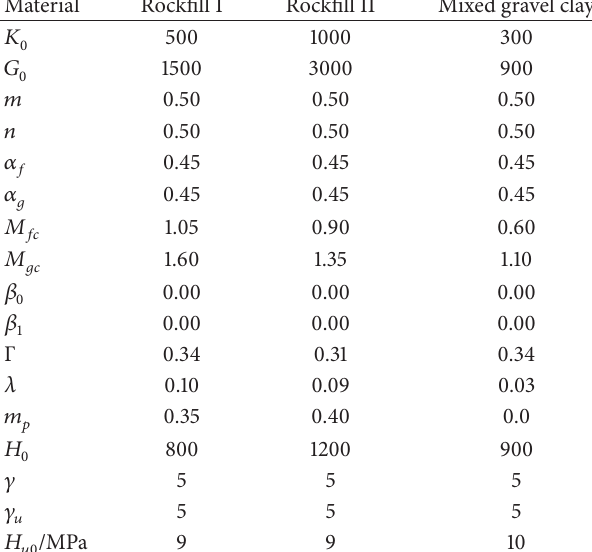
Figure 13: Comparison between in situ monitoring settlement and FEM results. Table 2: Material parameters of the modified PZ-III model. Material